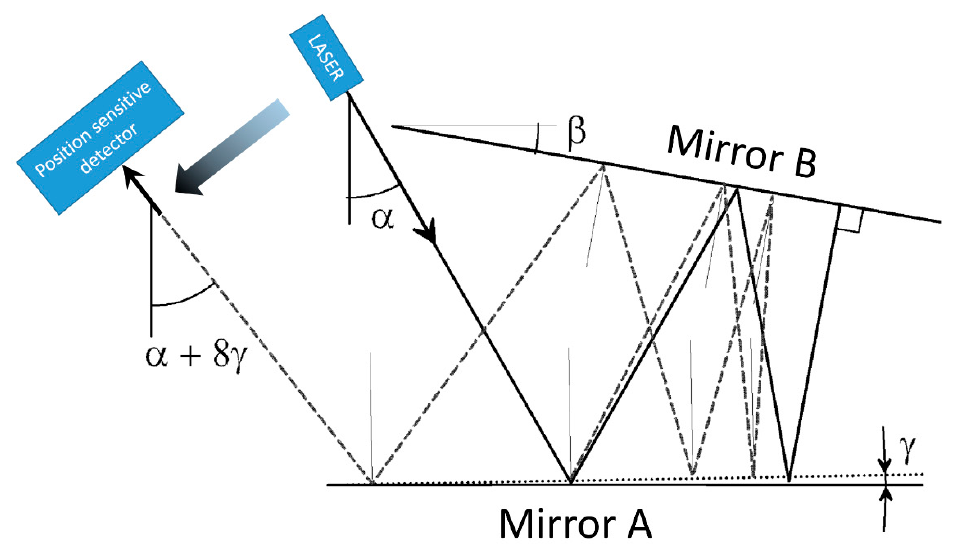
Figure 1. Ray tracing of the multiple reflection set-up showing the effect of the counter clockwise rotation of mirror A on the reflected beam. All angles in the figure are excessive for the sake of clarity. Incidence angle α is 30°; angle β between A and B is 10°; mirror B is rotated by γ = 1°. In the initial condition, after three reflections ( α / β = 3) the laser beam impinges orthogonally on mirror B and is reflected back on its path. This auto collimation condition is close to the operative condition of the device. When mirror A is rotated by 1° counter clockwise, the beam is moved towards left and is rotated by 8 times γ .